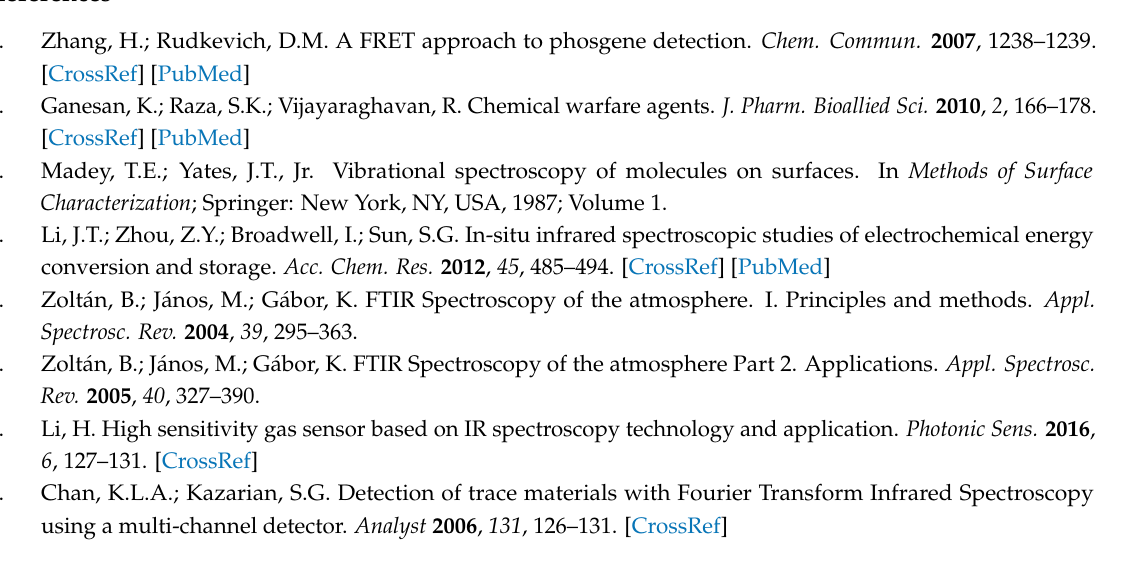
Supplementary Materials: Supplementary Materials are available online. Molecular spectra computed with different levels of theory (a .xlsx file) and molecular structure of A232 (a .xyz